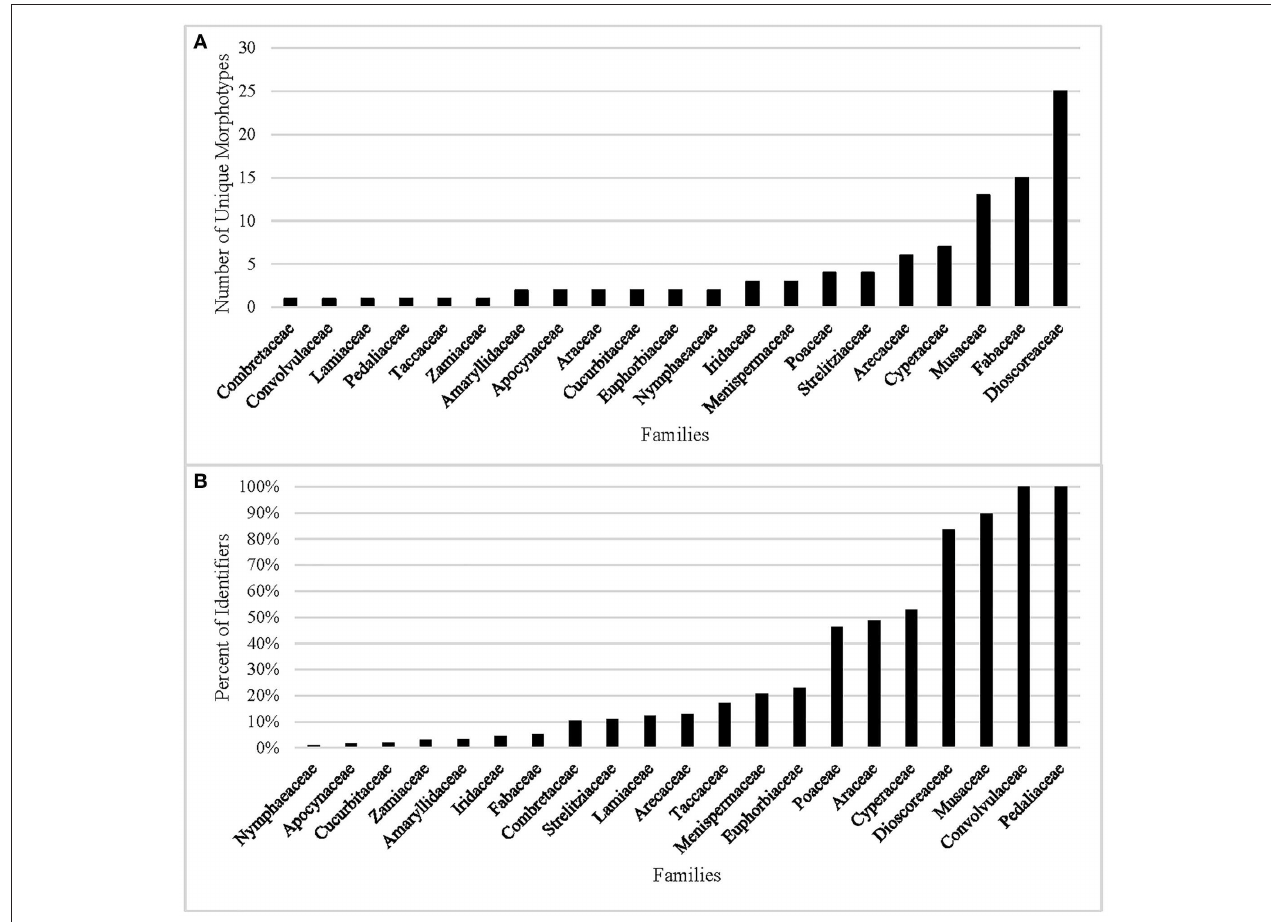
FIGURE 2 | (A) Number of morphometric identifiers per family, (B) Percent of granules displaying unique morphology from the total count per family.